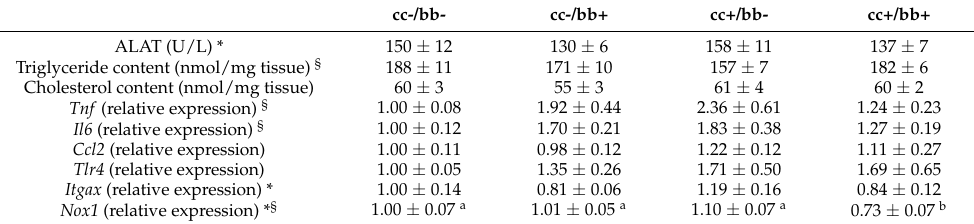
Table 2. Hepatic parameters related to lipid accumulation, inflammation and hepatotoxicity. cc-/bb- cc-/bb+ cc+/bb-